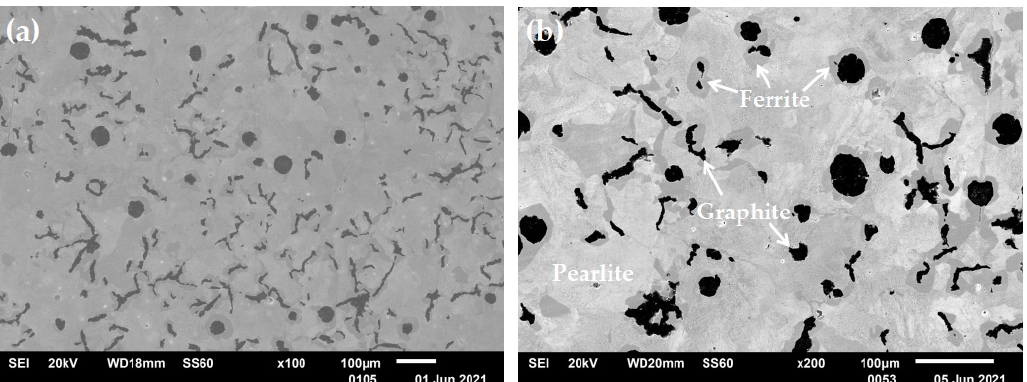
Figure 4. Microstructure of compacted graphite iron. ( a ) ×100; ( b ) ×200 .